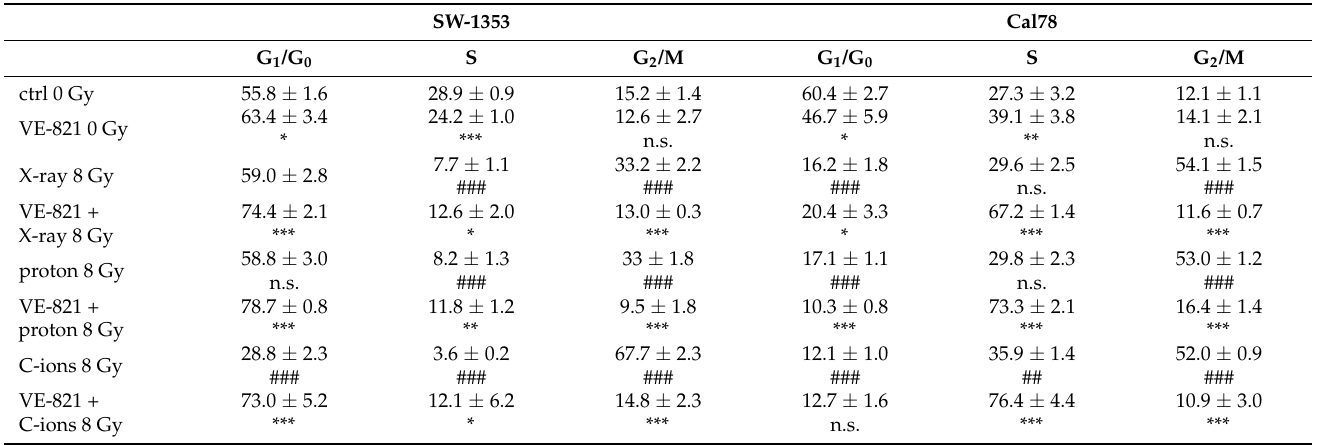
Table 1. Cell cycle distribution of chondrosarcoma cells 24 h after combined treatment of 10 µ M VE-821 and 8 Gy X-ray/proton/C-ions IR ( n = 4; mean ± SD; n.s.: not significant; * p < 0.05, ** p < 0.01, *** p < 0.001 represent significances of the VE-821 effect; ## p < 0.01, ### p < 0.001 represent significances of irradiation).